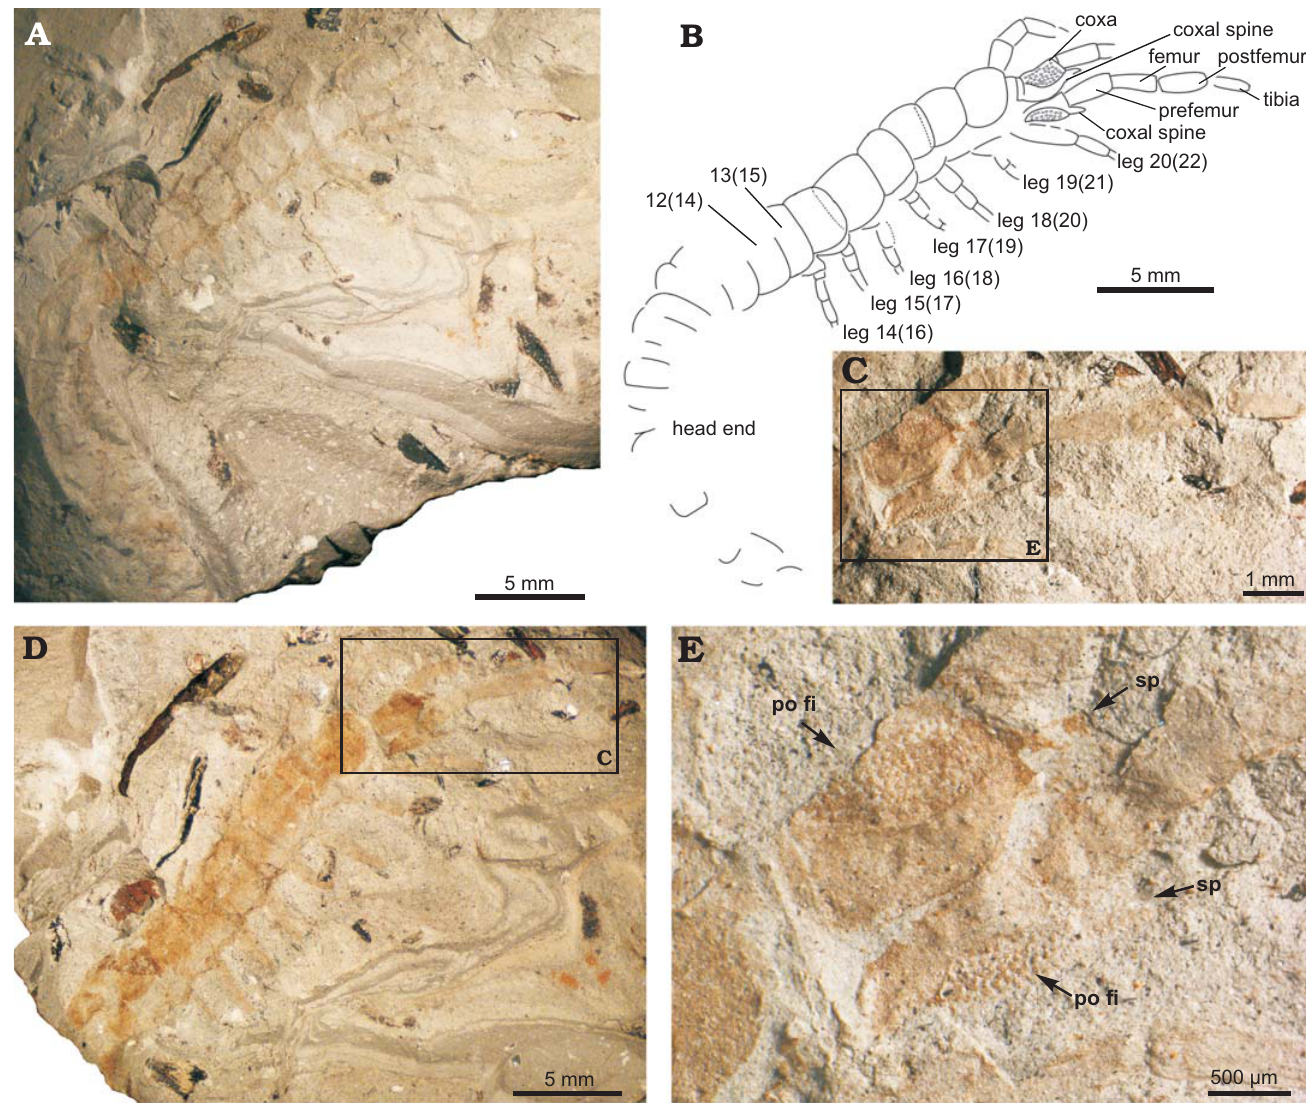
Fig. 2. Scolopendromorph chilopod Permocryptops shelleyi gen. et sp. nov., holotype, PIN 3840/3165, Isady locality, upper Permian of Russia. A , D . General view of part and counterpart (mirror-reversed), respectively. B . Drawing compiled from part and counterpart. C . Ultimate legs. E . Pore fields and ventrodistal spines on the ultimate coxae. Abbreviations: po fi; pore field, sp, coxal spine; numbers in parentheses are segment numbers assum- ing 23 segments are